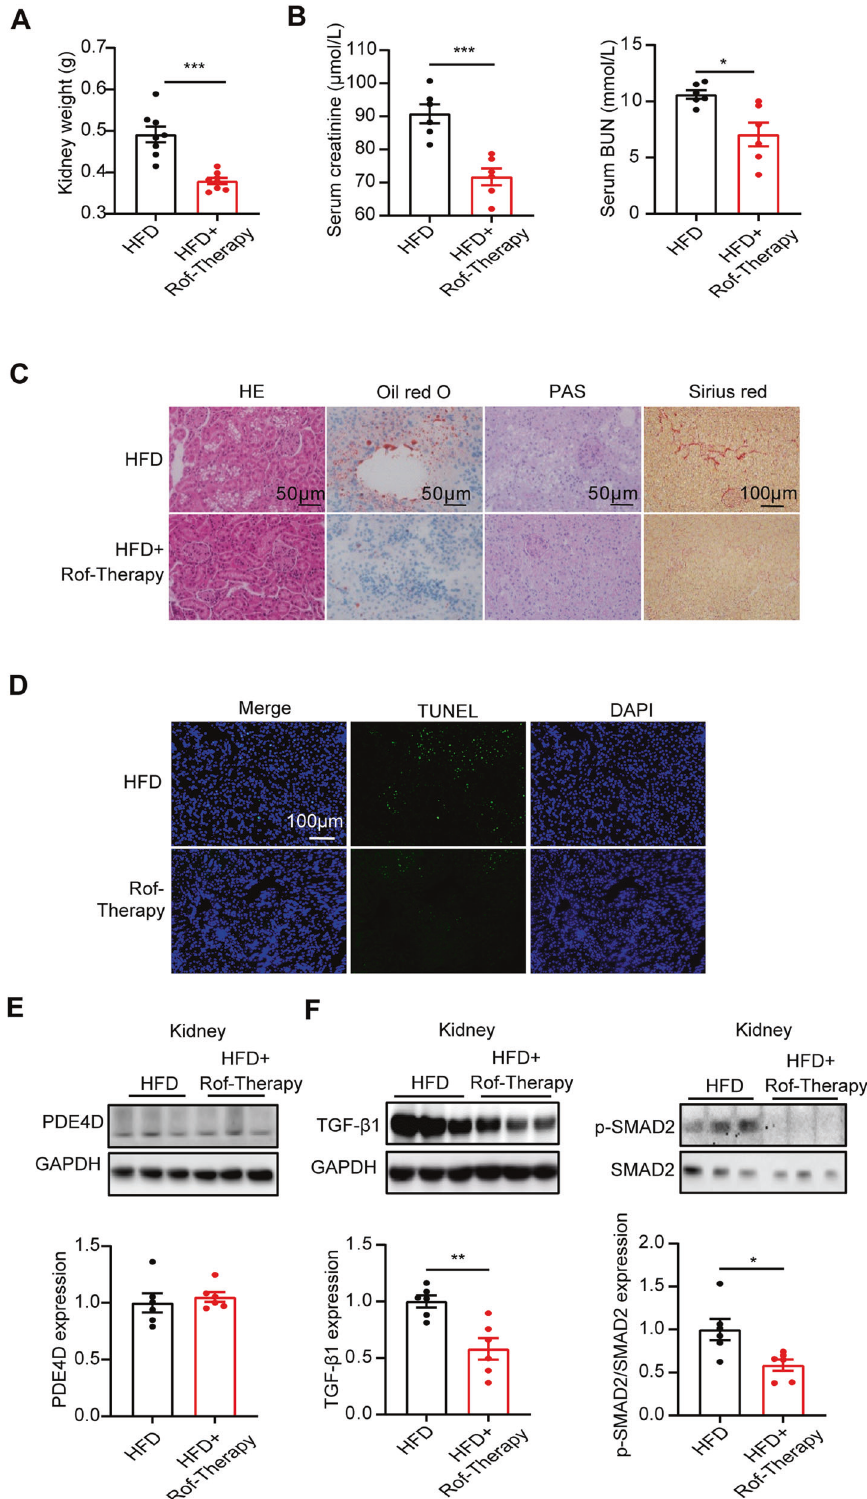
Fig. 6 The PDE4 inhibitor ro fl umilast alleviated renal injury induced by a high-fat diet. Ro fl umilast treatment (Rof-Therapy) started from 16 weeks post-HFD and lasted for 4 weeks. A Kidney weight of HFD and Rof-Therapy mice. B Serum creatinine (left) and BUN (right) levels of the two groups of mice. C HE, Oil red O, PAS, and Sirius red staining of mouse kidney. D TUNEL staining in kidney tissue of HFD and Rof- Therapy mice. E Western blot analysis of the protein levels of PDE4D in the kidneys of the two groups of mice. F Western blot analysis of the protein levels of TGF- β 1 and p-SMAD2/SMAD2 in the kidneys of the two groups of mice. Data are shown as the means ± SEMs. * P < 0.05, ** P < 0.01, *** P < 0.001 with a two-tailed Student ’ s t test.